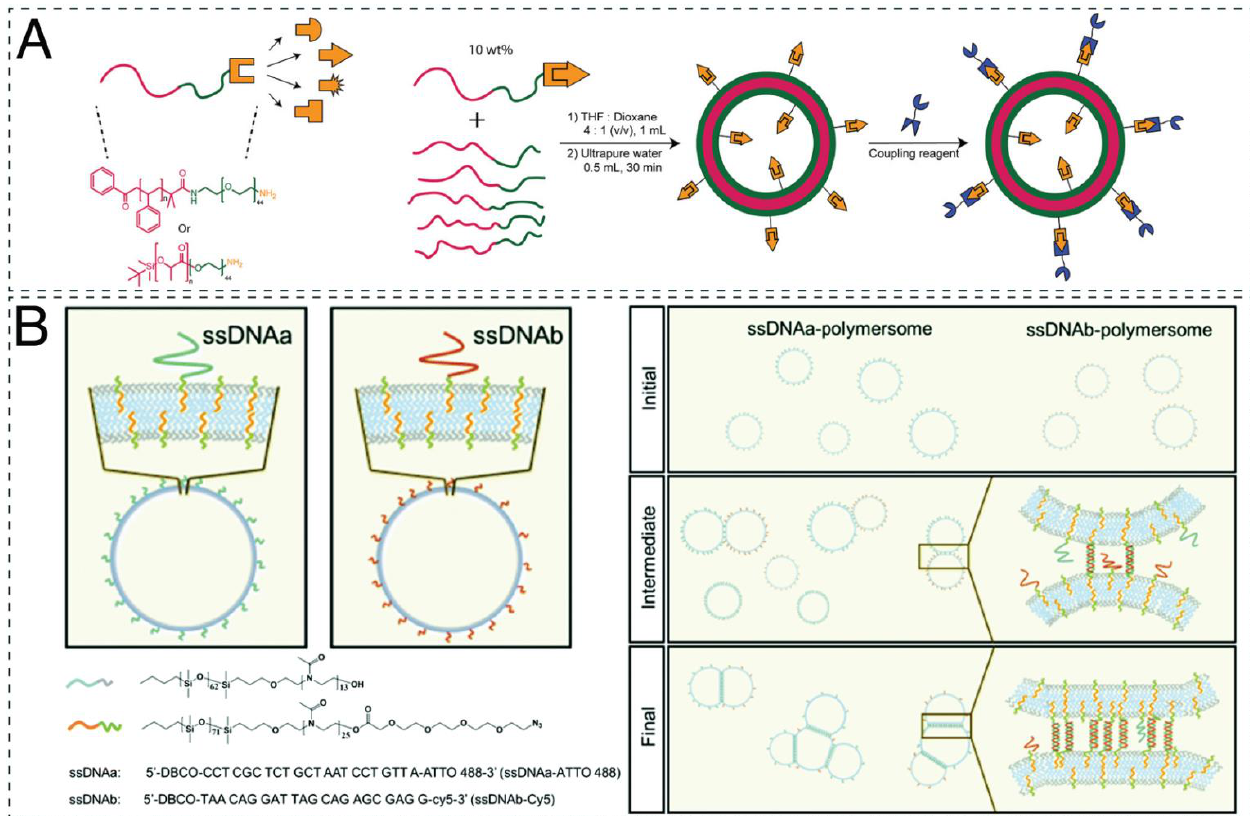
Figure 1. ( A ) Structure of the modular PEG- b -PS and PEG- b -PDLLA polymer with amine moiety used for attaching various functionalities. Functionalized PEG- b -PS and PEG- b -PDLLA polymers are self-assembled into polymersomes upon the addition of water. Functionalized polymers can be used for further decoration of polymersomes. Adapted with permission from [117]. Copyright 2020 ical structures of the block copolymers and ssDNA sequences used for assembly and step-by-step clustering process of ssDNA-polymersomes. Polymersomes link via DNA hybridization, which is followed by migration of the nonhybridized ssDNA and the formation of a DNA bridge area.